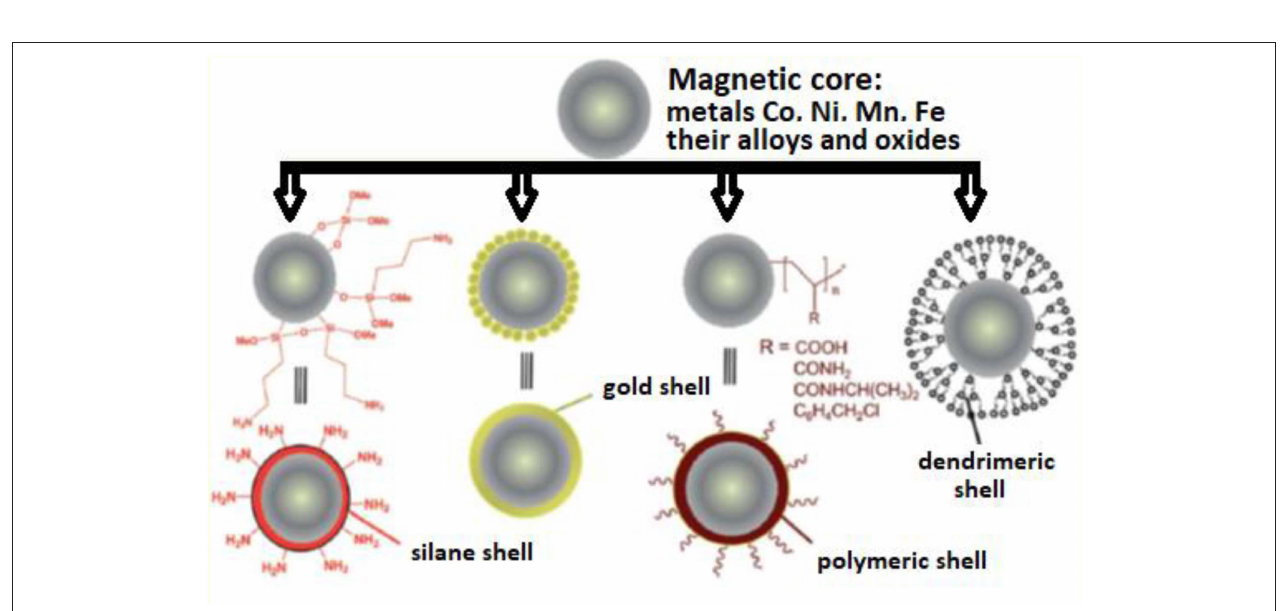
FIGURE 8 | Transition metal/metal oxides magnetic core-shell nanoparticles [adapted and modified from Kharissova et al.